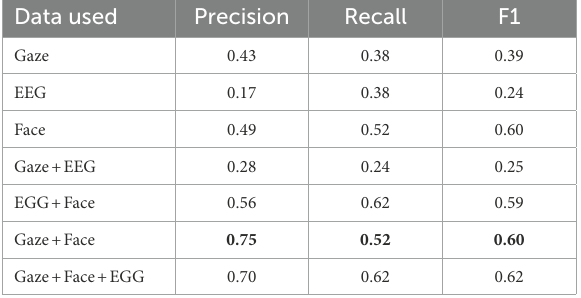
Bold values represent best performance. TABLE 4 Behavioral engagement prediction results. Data used